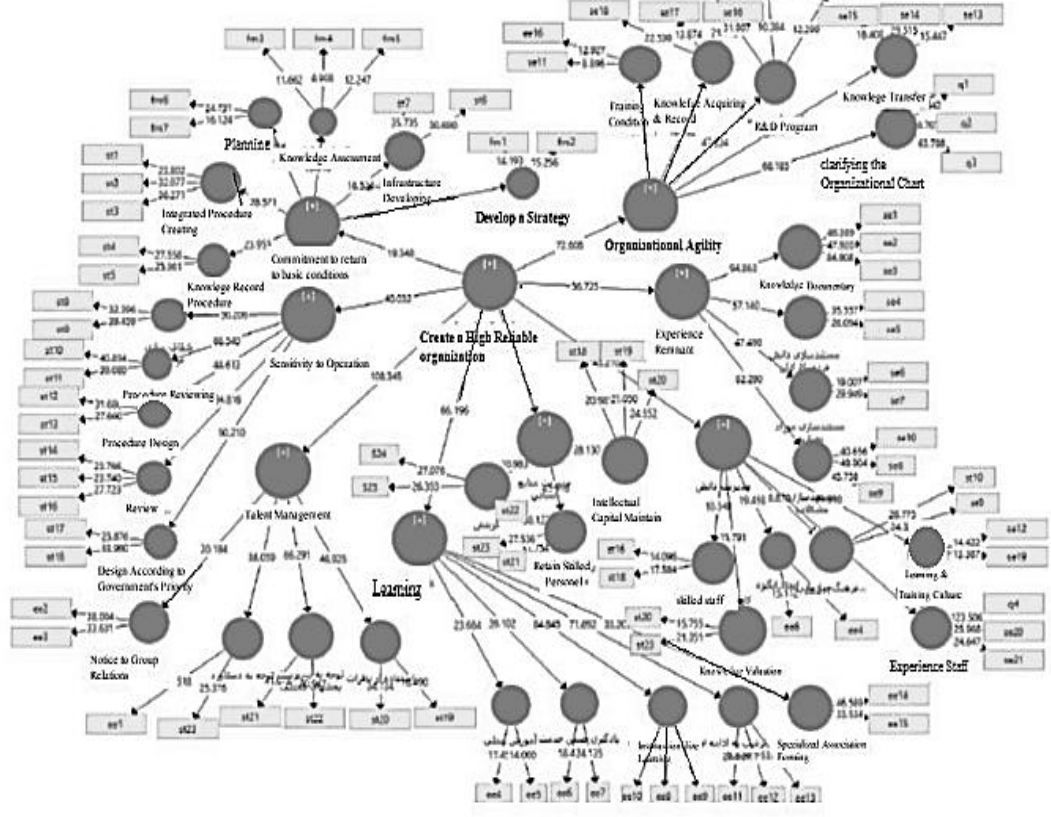
Fig. 3. Measurement model output in Smart PLS software (source: software